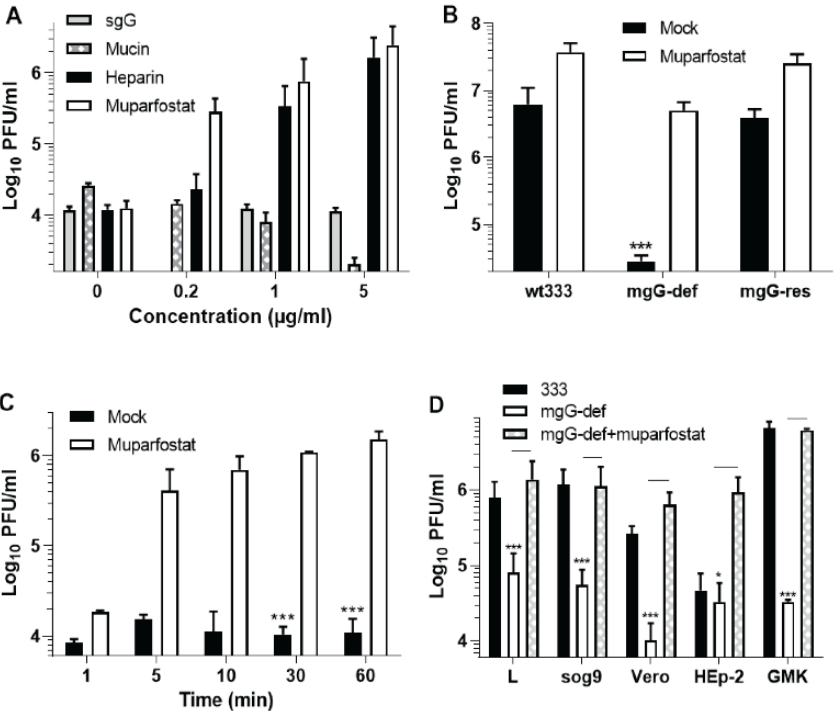
Figure 4. Forcible liberation of the mgG deficient HSV-2 from the surface of infected cells. ( A ) GMK AH1 cells were infected with the mgG-deficient (mgG-def) mutant virus at multiplicity of infection of 1 for 2 h at 37 °C, then rinsed twice with Eagle´s medium and incubated for further 22 h in the same medium supplemented with specific concentrations of secreted gG (sgG) of HSV-2, mucin, heparin, and muparfostat. The concentrations of mucin were 2000 times higher than indicated in the graph. ( B ) GMK AH1 cells were infected with HSV-2 strain 333 (wt333), the mgG-def, and the mgG-proficient recombinant virus (mgG-res) and then incubated with muparfostat (10 µg/mL) as described above. ( C ) GMK AH1 cells were infected with the mgG-def as described in part ( A ) and subjected to short treatments with muparfostat (10 µg/mL) beginning at 24 h after infection. ( D ) Murine L and mutant sog9 cells as well as Vero, HEp-2 and GMK AH1 cells were infected with wt333 or the mgG-def, and the cells infected with the latter virus were subjected to muparfostat (10 µg/mL) treatment as described in part ( A ). The virus titers (PFU/mL) were quantified in infectious culture supernatant medium and all values shown are means (±SD) of data from two to four separate experiments performed in duplicates. Statistically significant differences at p values of <0.005 (***) or <0.05 (*).